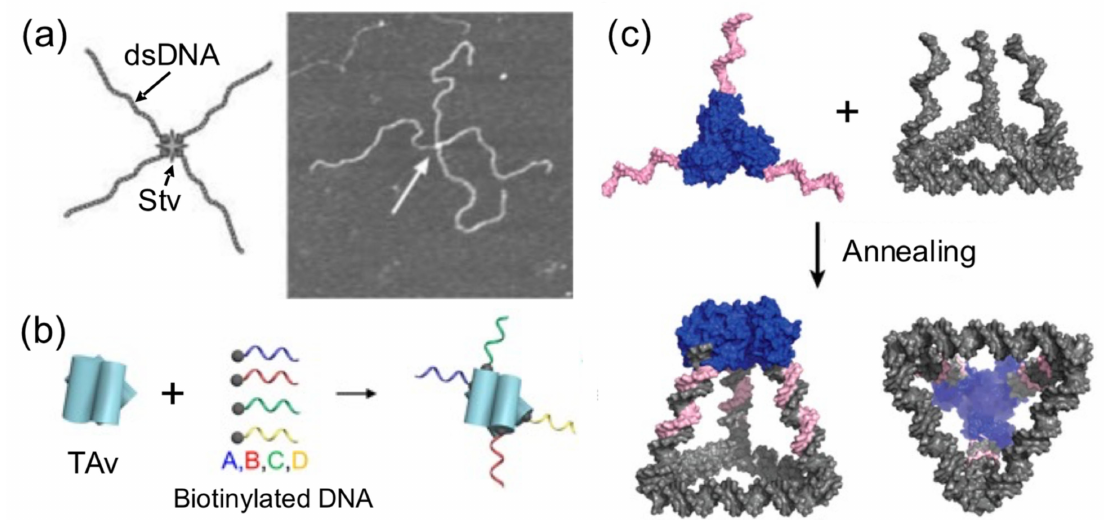
Figure 5. Proteins direct and organize DNA in space. ( a ) Streptavidin (Stv) tetramers binds to 4 copies of a biotinylated dsDNA (left). AFM image (right). Adapted from [40], with permission from Royal Society of Chemistry, 2006. ( b ) Traptavidin (TAv) tetramer self-assembles four biotinylated ssDNA oligonucleotides. Adapted from [42], with permission from American Chemical Society, 2019. ( c ) 3D nanocages are formed between the assembly of a triangular DNA nanostructure carrying complementary oligos in its vertices with a protein trimer conjugated to complementary oligonucleotides. Adapted from [21], with permission from American Chemical Society,